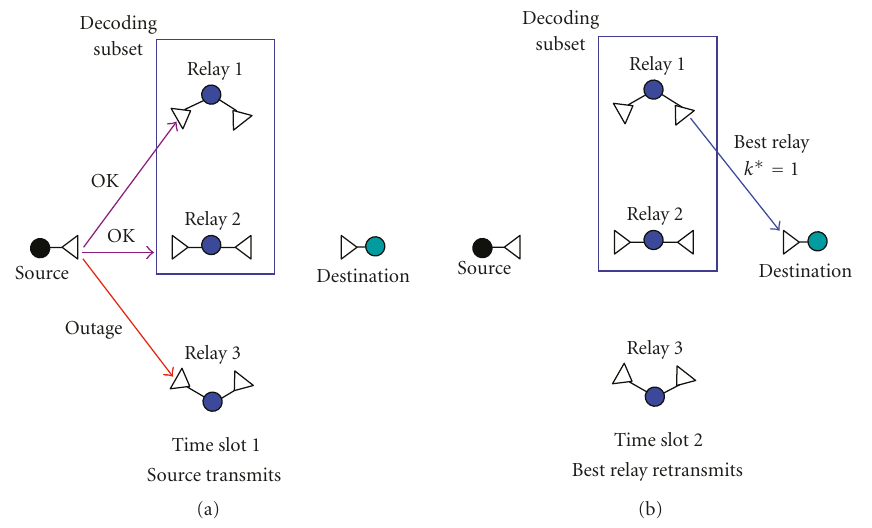
Figure 2: Cooperative communications scheme based on ORS with